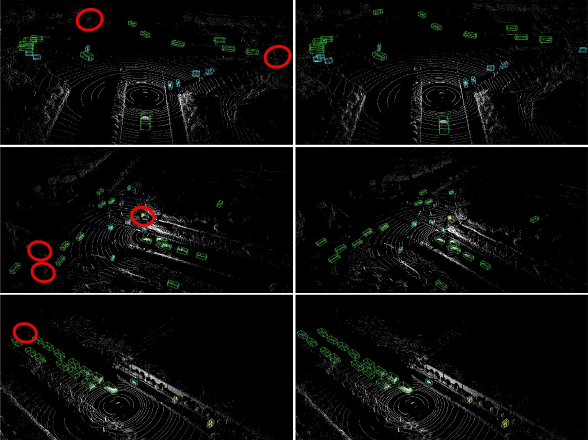
Figure 7. Visual detection results for CenterPoint ( left ), and Centerpoint-FE ( right ).